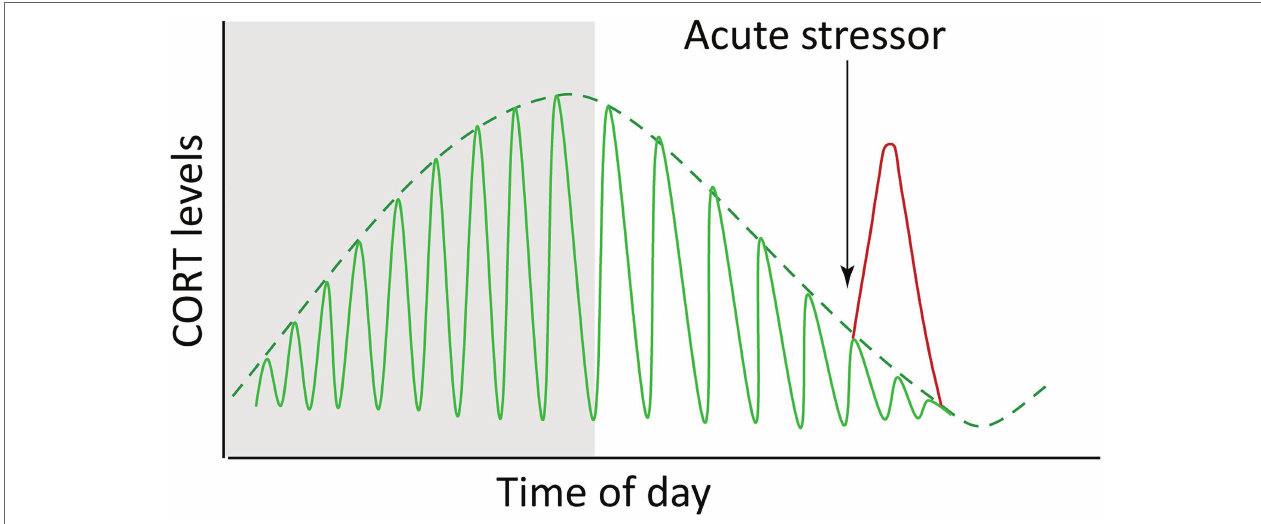
FIGURE 3 | Endogenous glucocorticoids (cortisol and corticosterone, CORT) fluctuate both with circadian and ultradian rhythms (green lines) and in response to acute stress (red line). The idealized graph depicts the situation in a diurnal animal (i.e., with a waking phase during daylight hours; nighttime is depicted by shading). The circadian dynamics are reversed in nocturnal